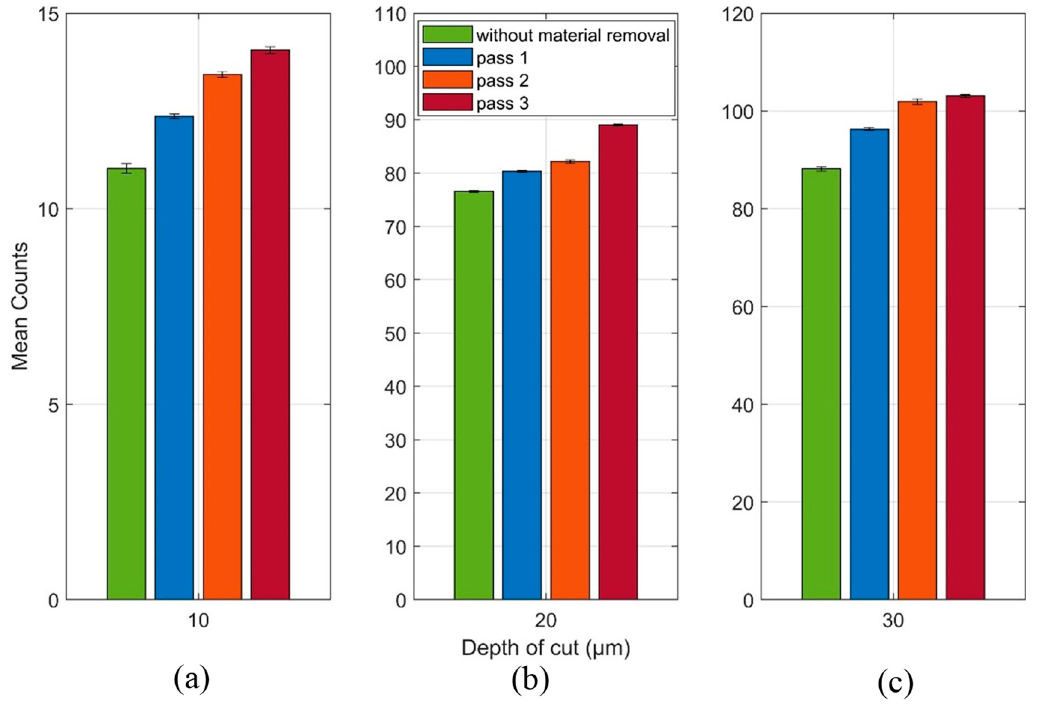
Figure 12. Counts and standard deviation values of the raw filtered signals at ( a ) 10 µm; ( b ) 20 µm and ( c ) 30 µm.